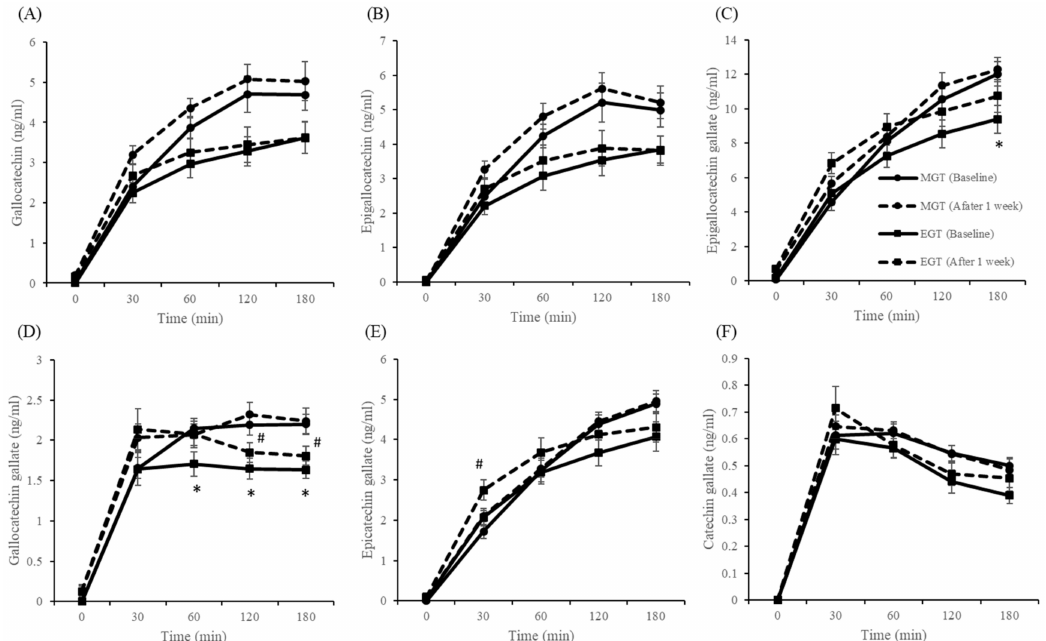
Figure 6. Fasting and postprandial plasma concentrations of gallocatechin ( A ), epigallocatechin ( B ), epigallocatechin gallate ( C ), gallocatechin gallate ( D ), epicatechin gallate ( E ), and catechin gallate ( F ). Data are expressed as the mean and SEM, represented by bidirectional bars. * Mean values were significantly di ff erent from that of MGT group at same meal time (baseline) ( p < 0.05), # Mean values were significantly di ff erent from that of MGT group at same meal time (after 1 week) ( p <